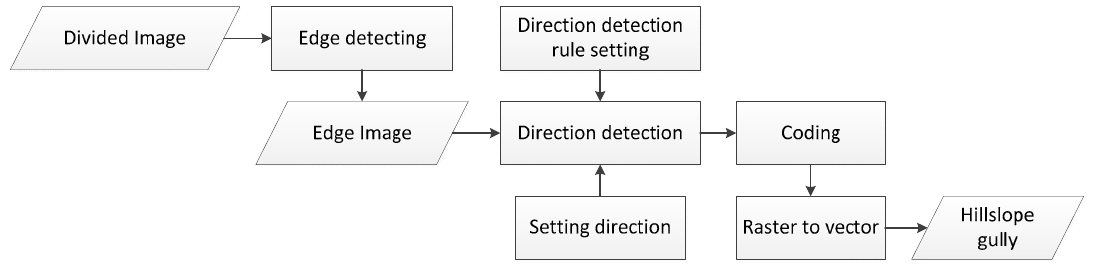
Figure 4. Workflow of ephemeral gully extraction.